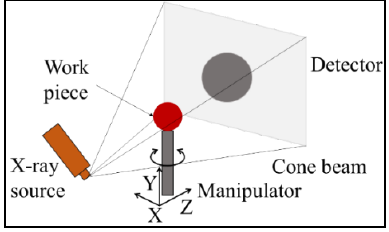
Figure 2: Typical cone beam XCT set up